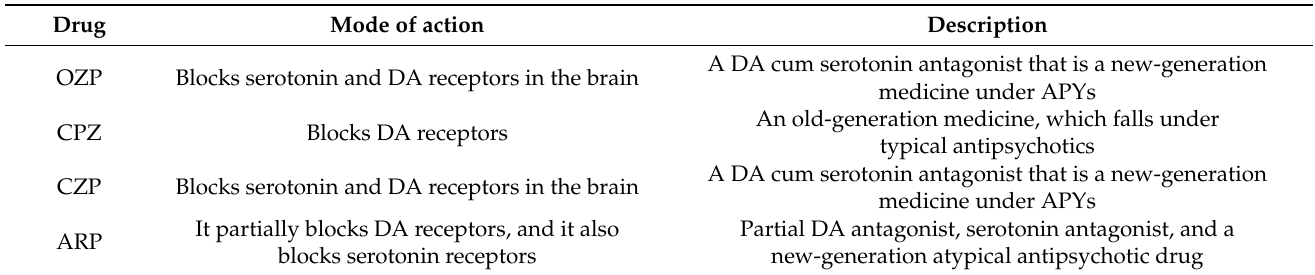
Table 3. OZP, CPZ, CZP, and ARP mode of action and